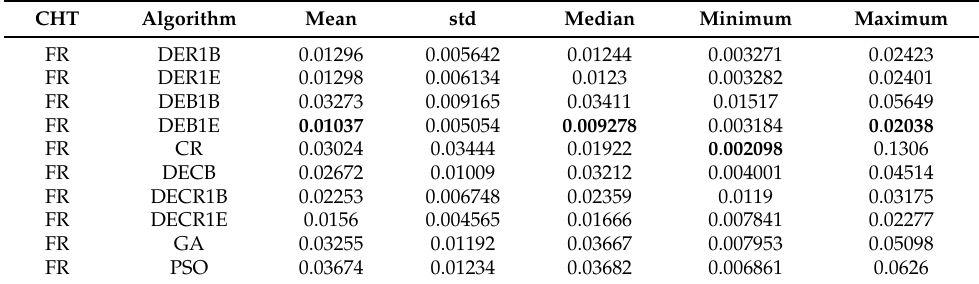
Descriptive statistics of the overall performance for study case 1: Four-bar linkage